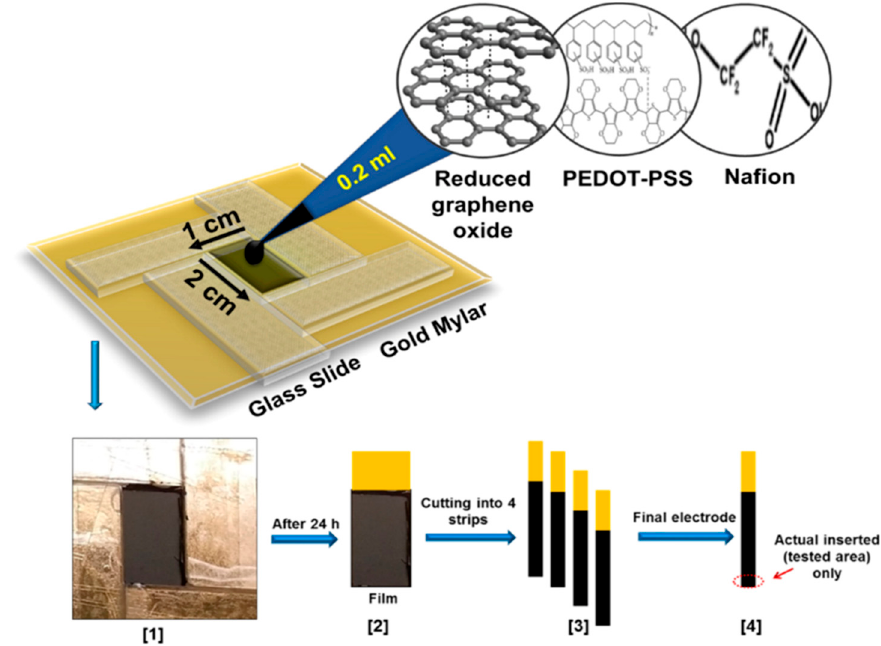
Figure 12. Schematic representation of the casting process of rGO − PEDOT/PSS-nafion composite onto gold mylar substrates. Reproduced with permission from [141]. Copyright 2019 American Chemical Society.